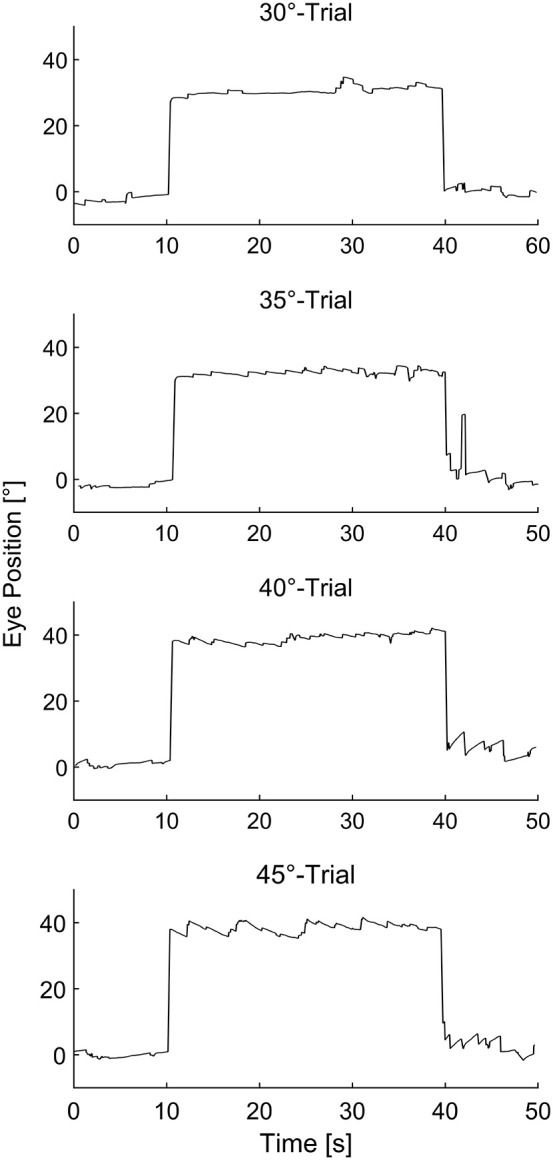
Representative eye movement traces of a single subject before, during, and after sustained eccentric gaze at 30°, 35°, 40°, and 45° respectively.